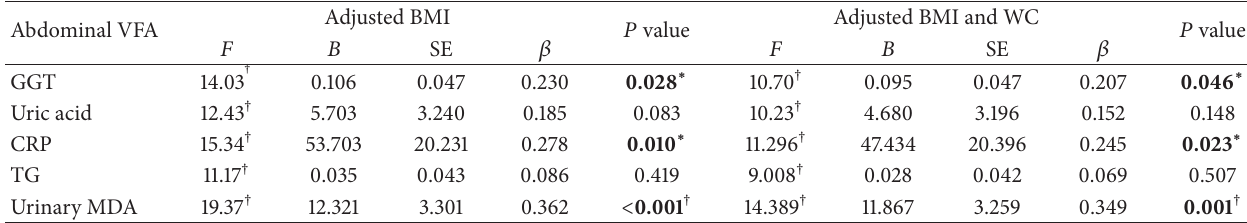
Table 3: Correlations between obesity indices, metabolic parameters, and urinary malondialdehyde levels. BMI WC Fat percent VFA SFA ALT 0.394 ∗ 0.305 ∗ 0.277 ∗ 0.154 0.384 ∗ † 0.335 † 0.380 † 0.389 † 0.376 † GGT 0.355 Uric acid 0.112 0.168 0.105 0.263 ∗ 0.066 CRP 0.343 † 0.346 † 0.290 ∗ 0.326 † 0.345 † TG 0.255 ∗ 0.274 ∗ 0.257 ∗ 0.254 ∗ 0.233 ∗ Urinary MDA 0.081 0.031 0.357 † 0.005